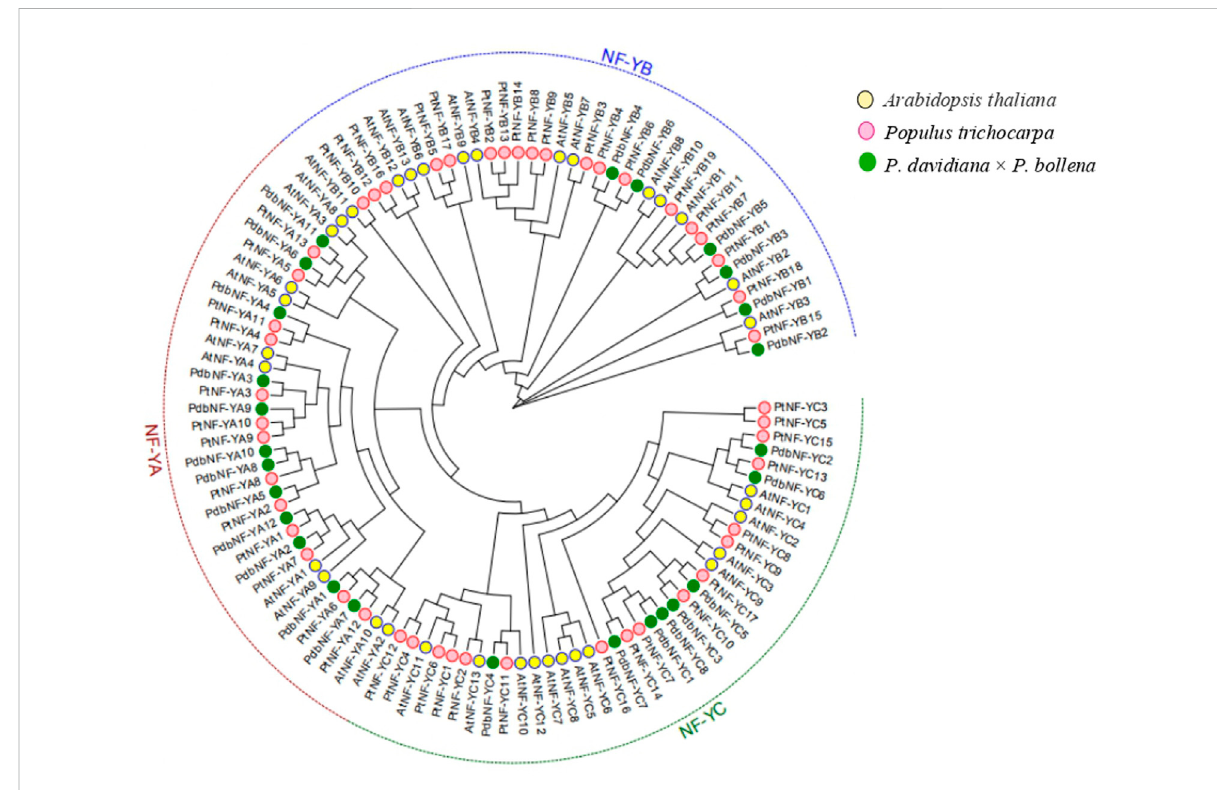
FIGURE 2 Phylogenetic analysis of the NF-Y TFs in poplar and Arabidopsis . All NF-Y TFs were clustered into three clades (NF-YA, NF-YB, and